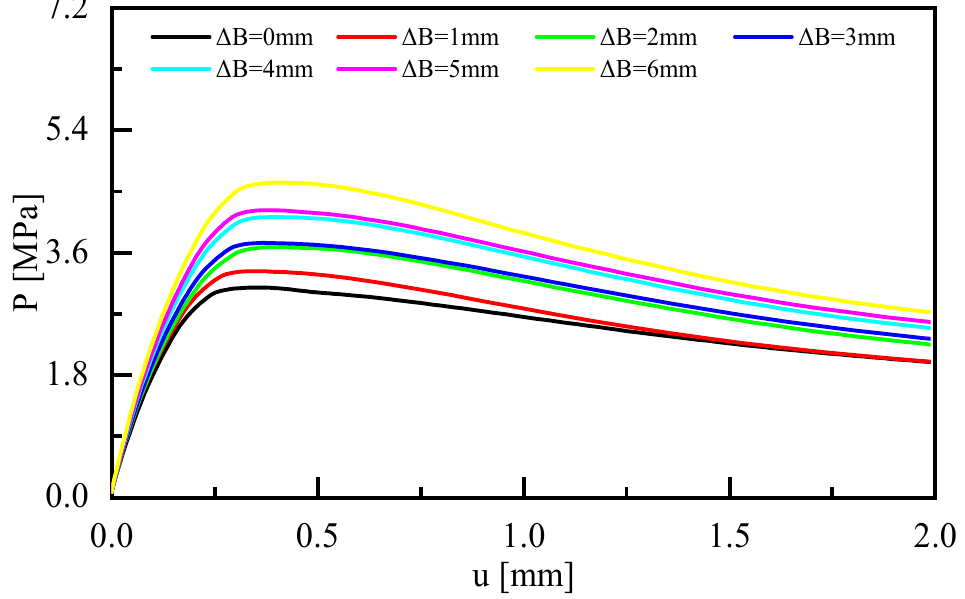
Figure 21. Equilibrium paths of bi-segment bulged hulls as obtained from numerical analysis at an imperfection size of 0.2𝑇 .